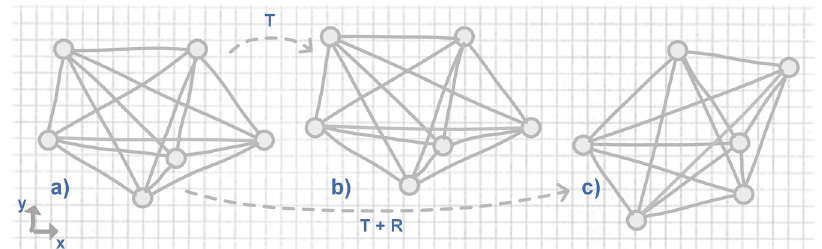
Figure 6. Depending on the desired invariance regarding translation T ( b ) and additionally rotation T + R ( c ) the shown constellations will be treated to be equal to ( a ).